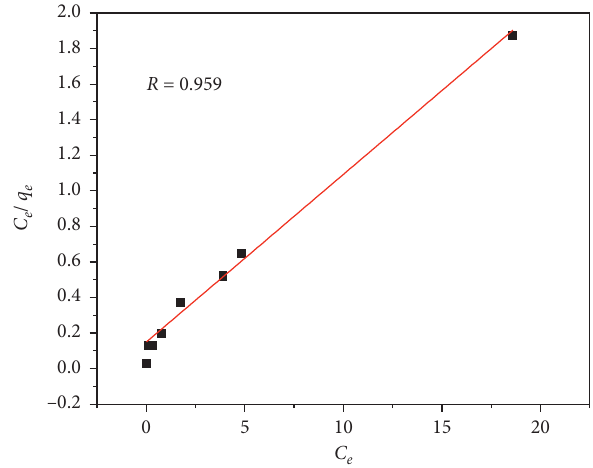
Figure 6: Langmuir model for brilliant green dye onto AC.